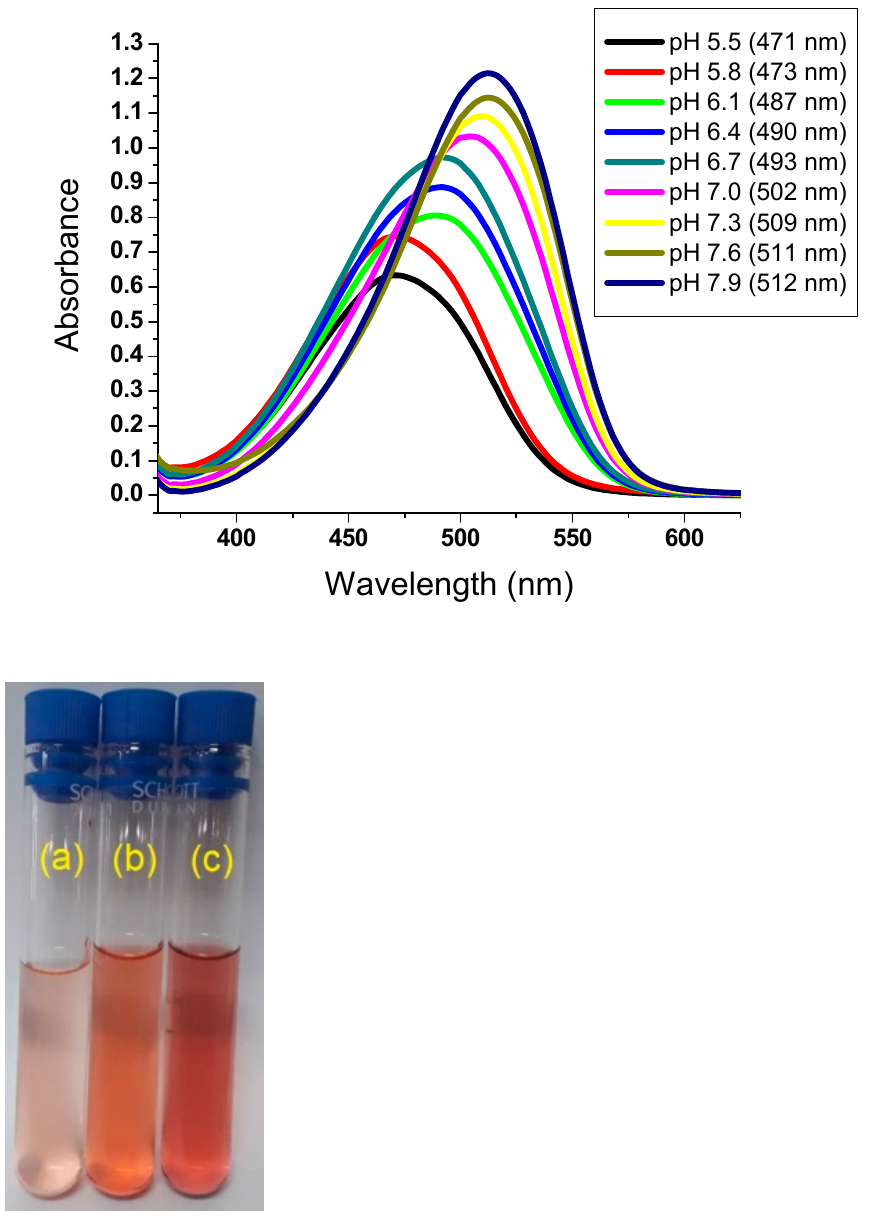
Figure 2. pH-dependent absorbance wavelength of DCDHFH in CH 3 CN (conc. 3.0 × 10 − 6 mol L − 1 ) at various pH levels ( top ), demonstrating color change between light orange ((a); pH 5.5), orange ((b); pH 6.7), and red ((c); pH 7.9) ( bottom ).